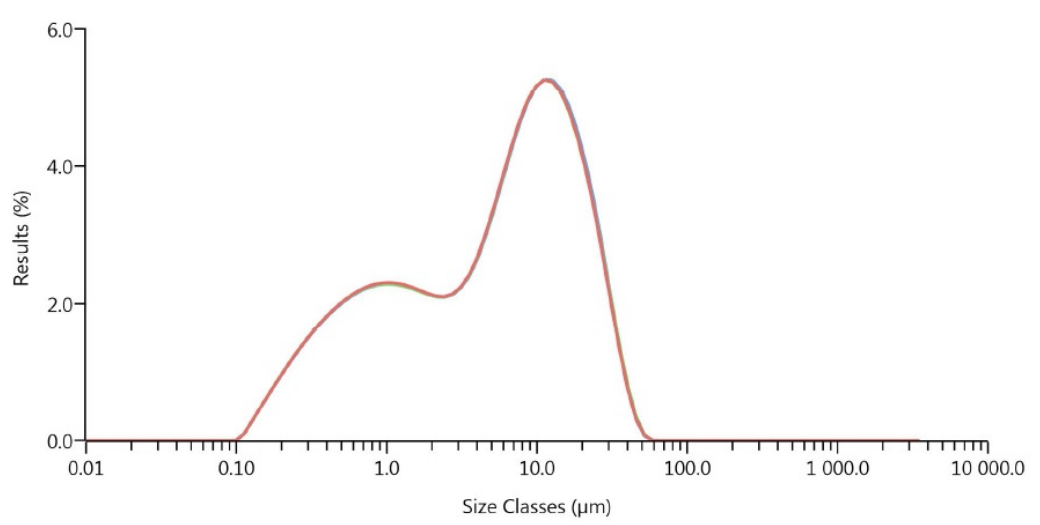
O powder particle size distribution curve (Mastersizer Figure 3. Al 2 3